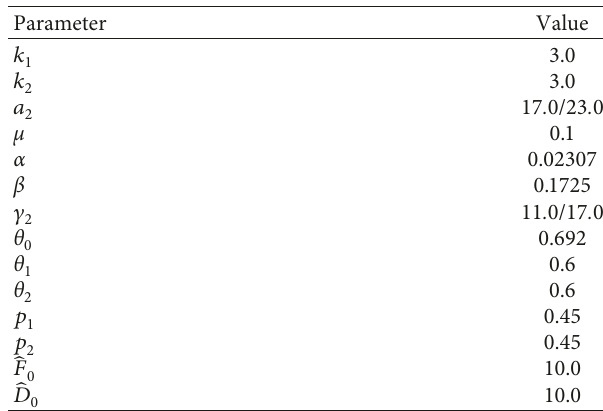
Figure 2: Diagram of the twin-rotor equalizing bar platform. Table 1: M1 parameters. Table 2: M2